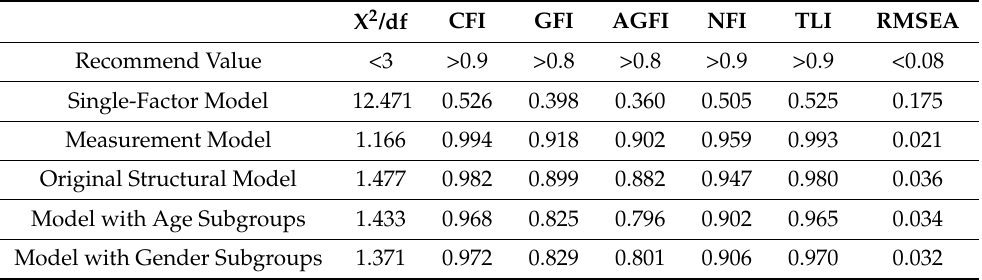
Table 5. The Model-fit of each model.